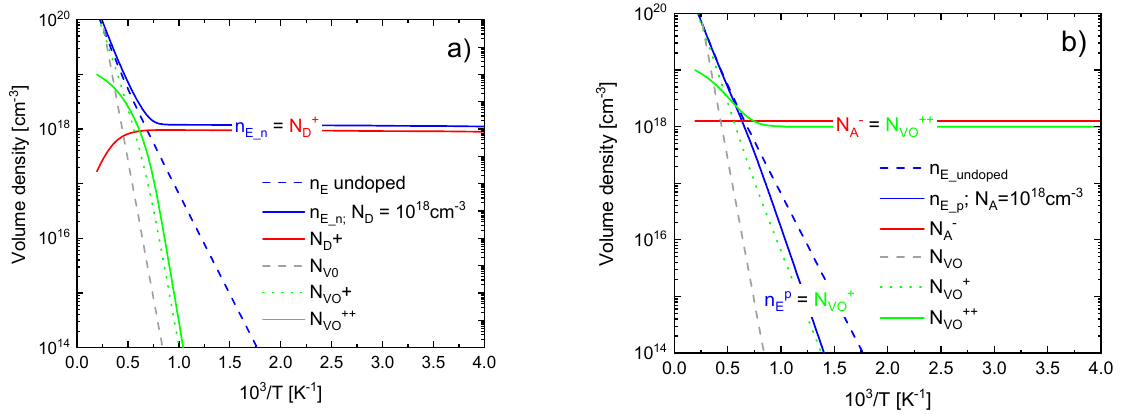
Figure 9. Effect of n-type ( a ) and p-type impurity doping ( b ) on mobile electron density and densities of the differently charged oxygen vacancy centers. Electron and positive donor densities in ( a ) and negative acceptor and twofold positive vacancy densities in ( b ) have been slightly displaced from their positive counterparts for clarity of presentation.